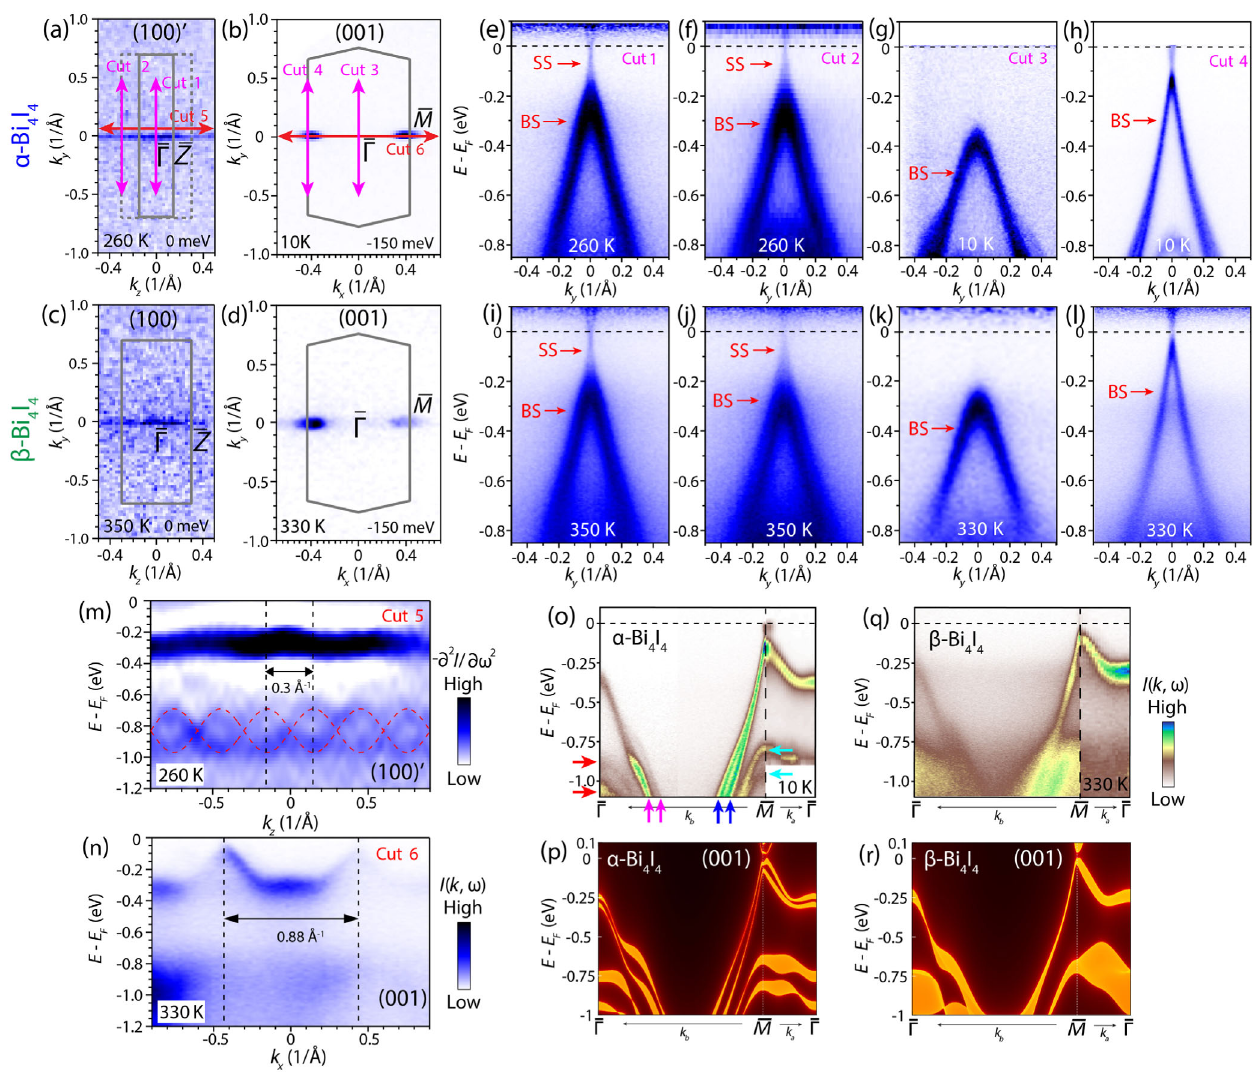
FIG. 2. Electronic structure from different surfaces. (a) Fermi surface mapping of α -Bi 4 I 4 on the ð 100 Þ 0 surface, with the surface BZ marked by gray rectangles (the solid one corresponds to α -Bi 4 I 4 and the dashed one to β -Bi 4 I 4 ). (b) Constant energy contour of α -Bi 4 I 4 on the (001) surface. (e) – (h) Measured band dispersions of α -Bi 4 I 4 along the cut 1 to cut 4 indicated in (a) and (b). Related surface states (SS) and bulk states (BS) are marked by arrows. (c),(d) and (i) – (l) Same as the top row but for β -Bi 4 I 4 . All band images are divided by the Fermi-Dirac function. (m) Band image along the cut 5 except taken at k y ¼ 0 . Cut 5 was drawn intentionally off center to not block the Fermi surface image. The red dashed lines are sinusoidal fittings of the band image showing a periodicity of 0 . 3 Å − 1 due to band doubling, which corresponds to the ð 100 Þ 0 surface. (n) Band image along the cut 6 indicated in (b). The black arrow shows a periodicity of 0 . 88 Å − 1 which corresponds to the (001) surface. (o) Measured dispersions in α -Bi 4 I 4 along high symmetry cuts. (p) Calculated bulk band structure of α -Bi 4 I 4 projected onto the (001) surface (see Supplemental Material [33]). (q),(r) Same as (o),(p) but for β -Bi 4 I 4 . A clear doubling of the bulk valence bands is evident from β -Bi 4 I 4 to α -Bi 4 I 4 in both the measured and calculated dispersions. All measurement temperatures are as